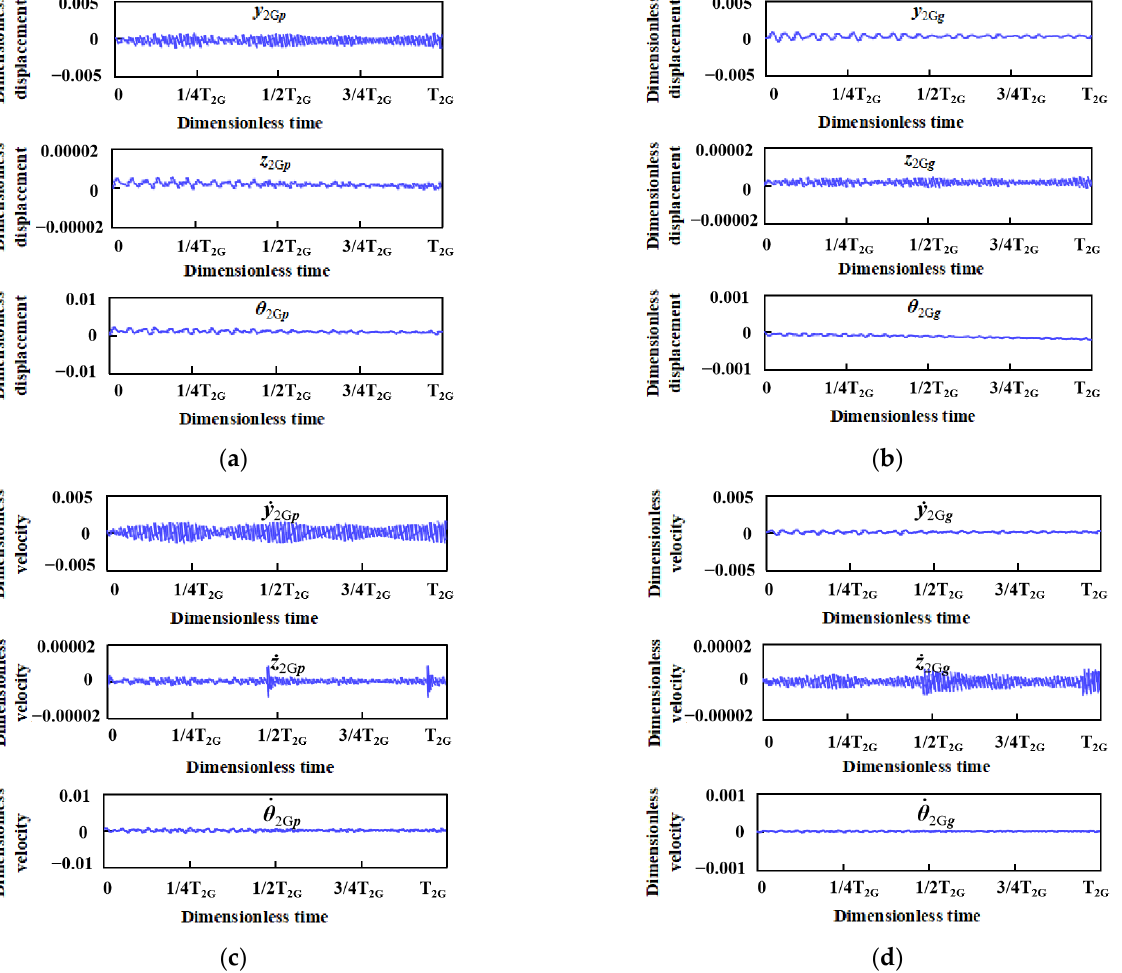
Figure 9. State space of the first-stage gear pair Z 3 and Z 4 : ( a ) vibration displacement of driving gear; ( b ) vibration displacement of driven gear; ( c ) vibration velocity of driving gear; ( d ) vibration velocity of driven gear.